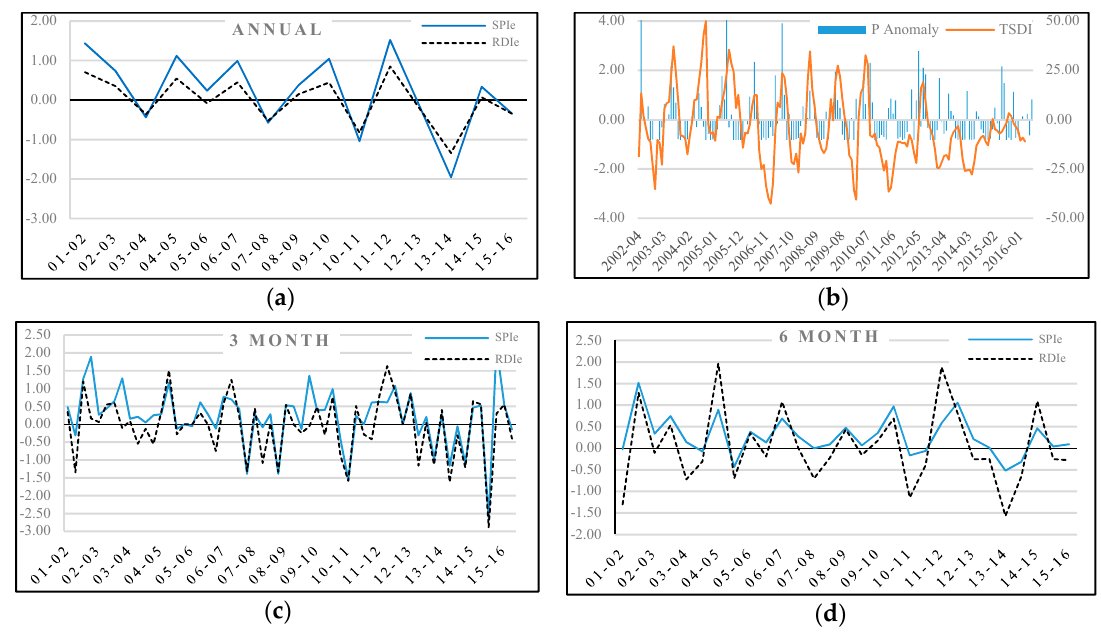
Figure 10. Drought detecting and monitoring in the arid zone of the studied area by ( a ) TSDI; ( b ) Annual SPI and RDIe; ( c ) SPI-3 and RDIe-3; ( d ) SPI-6 and RDIe-6. Table 7. The severity and duration of droughts in the arid zone of the studied area.